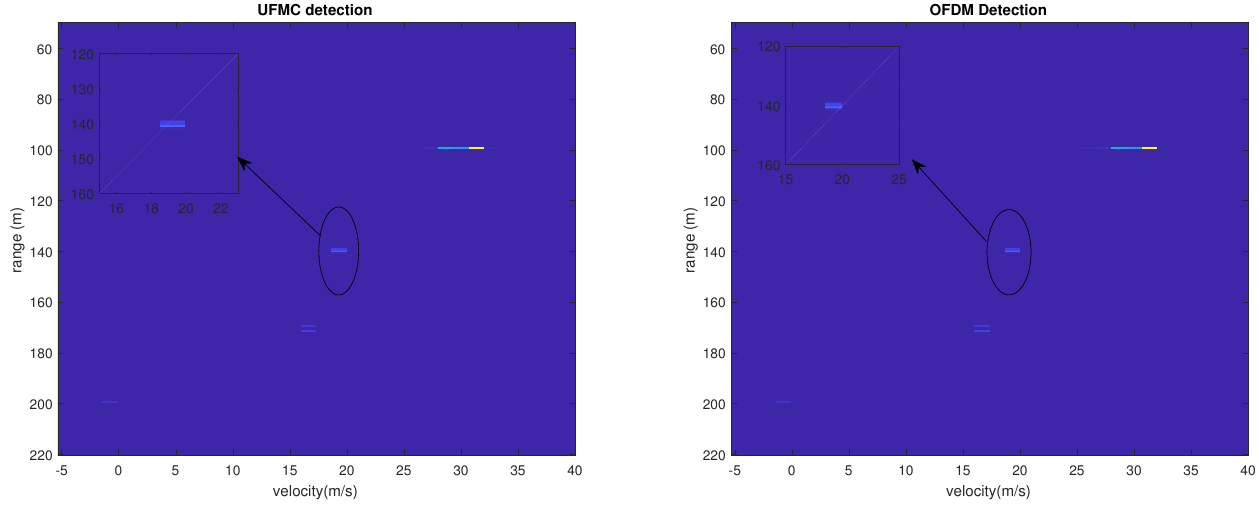
Figure 5. UFMC waveform vs. OFDM